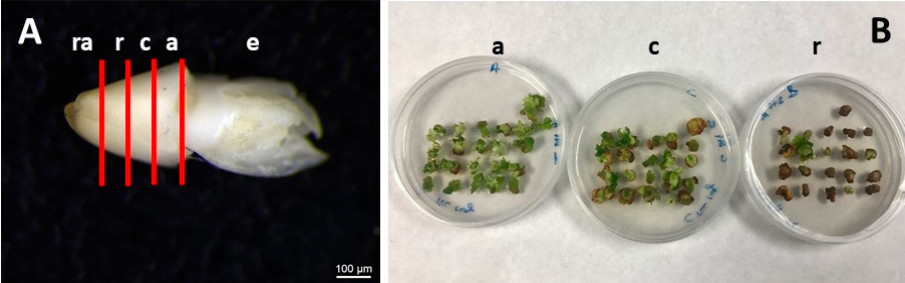
Figure 1. Shoot regeneration from ‘Canino’ apricot mature seeds hypocotyl slices ( A ) Different apricot hypocotyl slices used in this study: the slice near the epicotyl (a), the central slice (c), the slice near the ra€le (r). €cotyl (e) and radicle (ra) were not used. ( B ) Regeneration pattern from different hypocotyl slices (a, c and r).